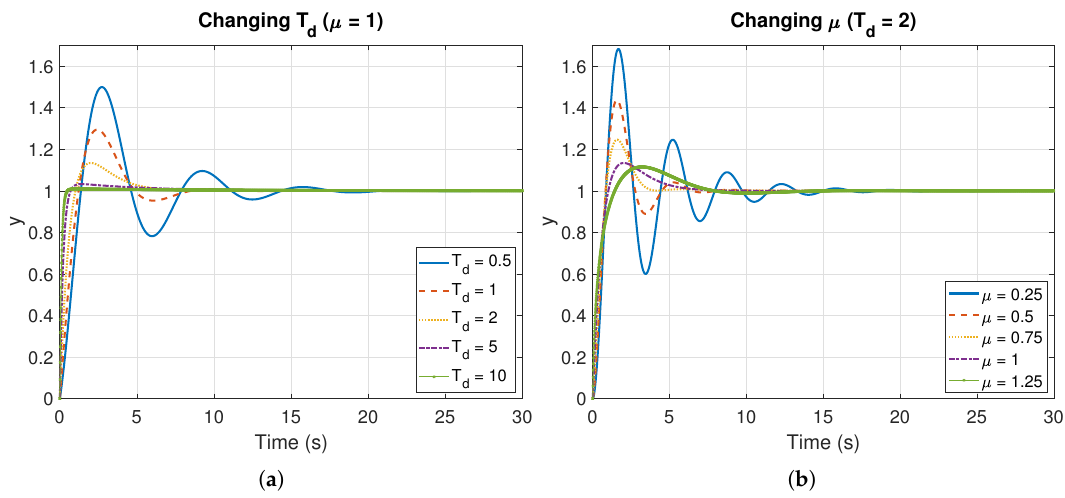
Figure 11. Step responses in closed-loop of system (19) controlled by fractional PD controller (20) when changing: ( a ) derivative time constant T i ( K p = 1, µ = 1) ( b ) integration order µ ( K p = 1, T d =